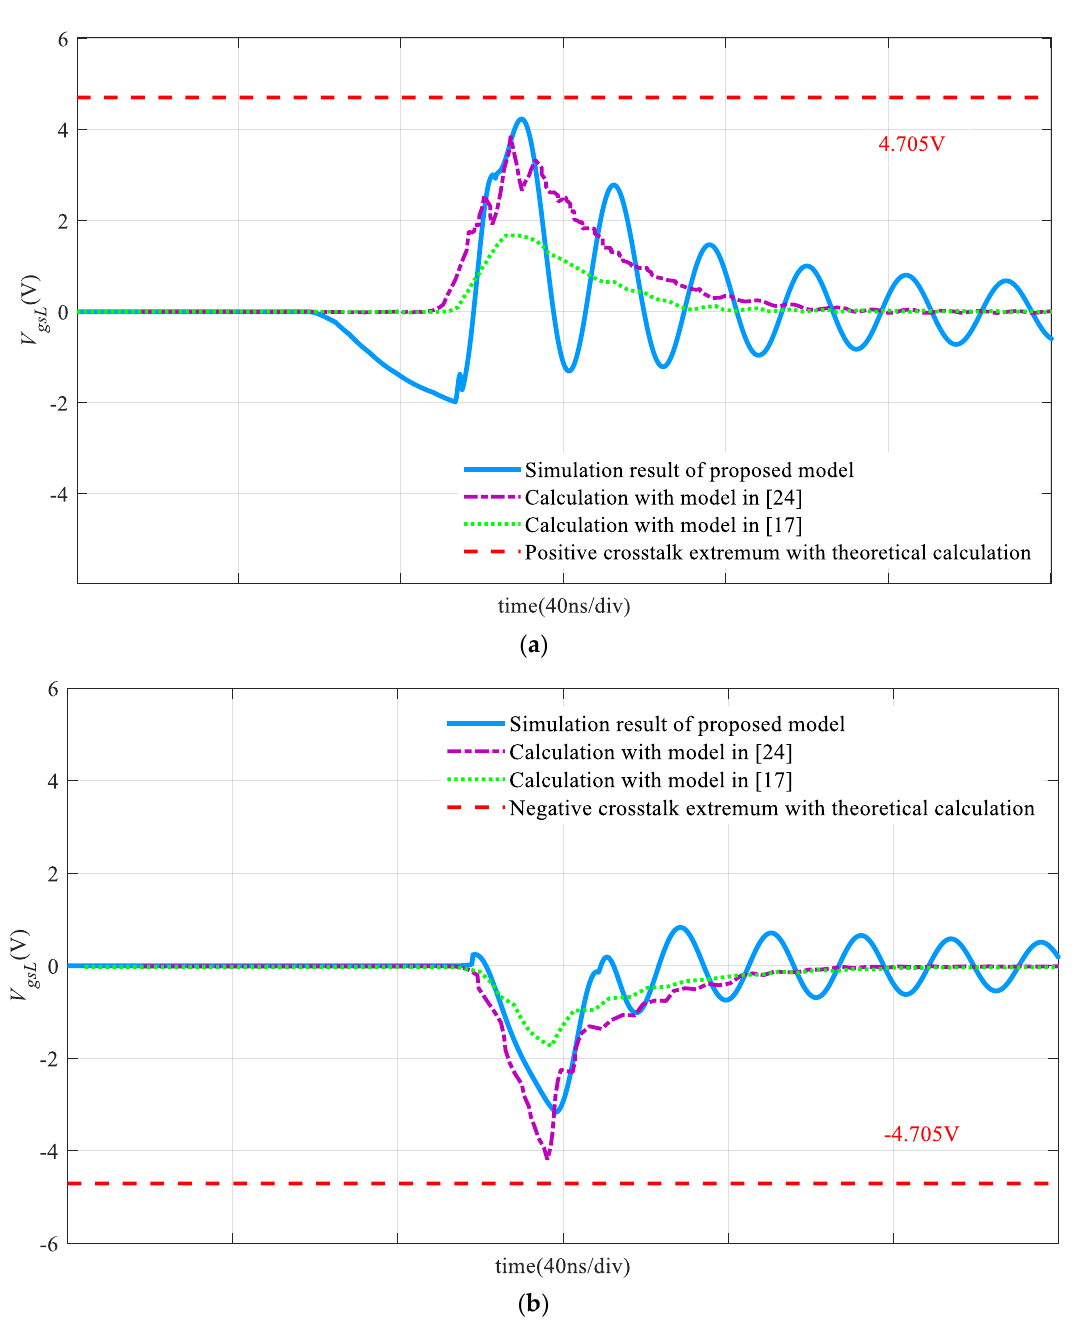
Figure 18. Crosstalk waveforms provided by the proposed analytical model, the analytical model in [17] the analytical model in [24], and the extremum calculated by theoretical calculation. ( a ) turn-on process. ( b ) turn-off process.